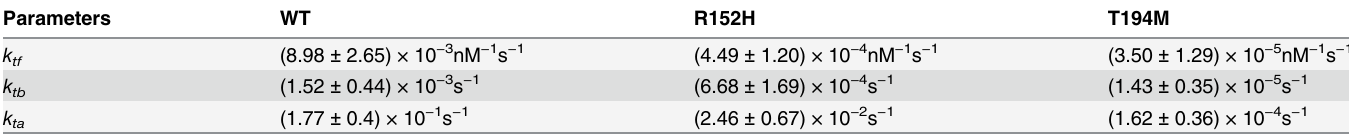
Table 3. List of optimized parameters used for the simulation of in vitro phosphorylation assay. Here, x ± y stand for the value of optimized parameter x with standard deviation y . The standard deviation is calculated using the data of 500 independent SA runs.